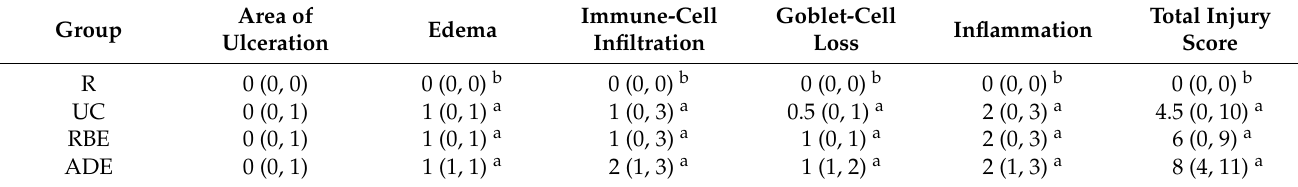
Table 4. Microscopic injury scores of the